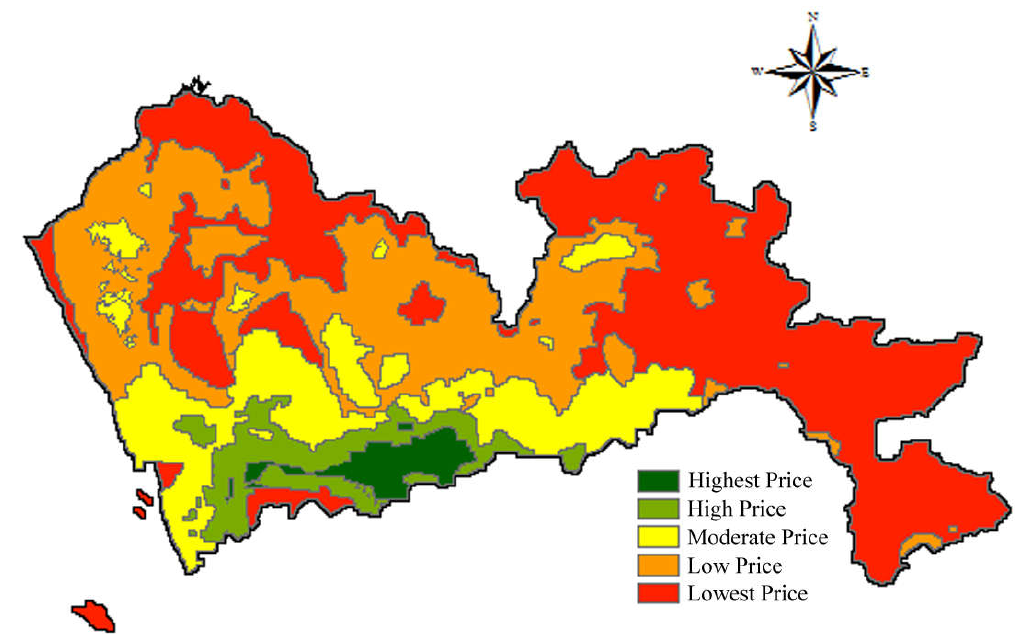
Figure 16. Map of land price.